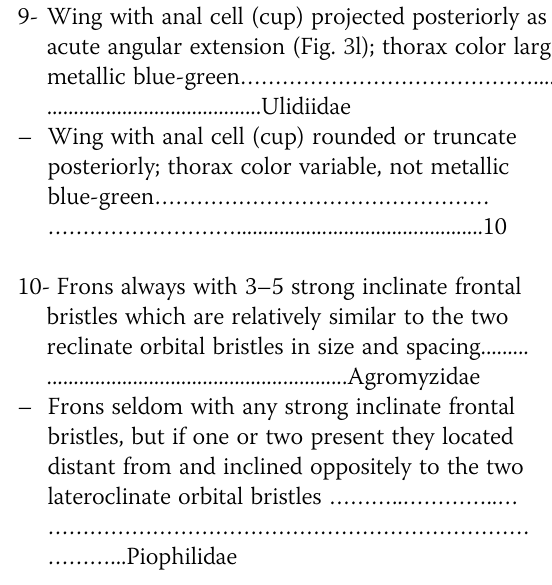
Fig. 1 a Chrysomya albiceps (Wiedemann, 1819), fore wing; b – d Calliphora vicina Robineau-Desvoidy,1830, b fore wing, c lower calypter, d adult; e , f Lucilia sericata (Meigen, 1826), e lower calypter, f adult; g, h Calliphora vicina Robineau-Desvoidy, 1830, g anterior thoracic spiracle lateral view, h halter wing; i, j Chrysomya megacephala (Fabricius, 1794) male, i anterior thoracic spiracle lateral view, j compound eye; k – l Chrysomya rufifacies (Macquart, 1842) male, k anterior thoracic spiracle lateral view, l compound eye; m, n Chrysomya albiceps (Wiedemann, 1819), m anterior thoracic spiracle lateral view, n adult; o Lucilia cuprina (Wiedemann, 1830), head ventral view; p Lucilia sericata (Meigen, 1826), head ventral